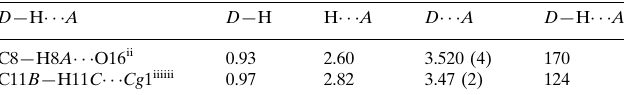
Hydrogen-bond geometry (A˚ , (cid:2)